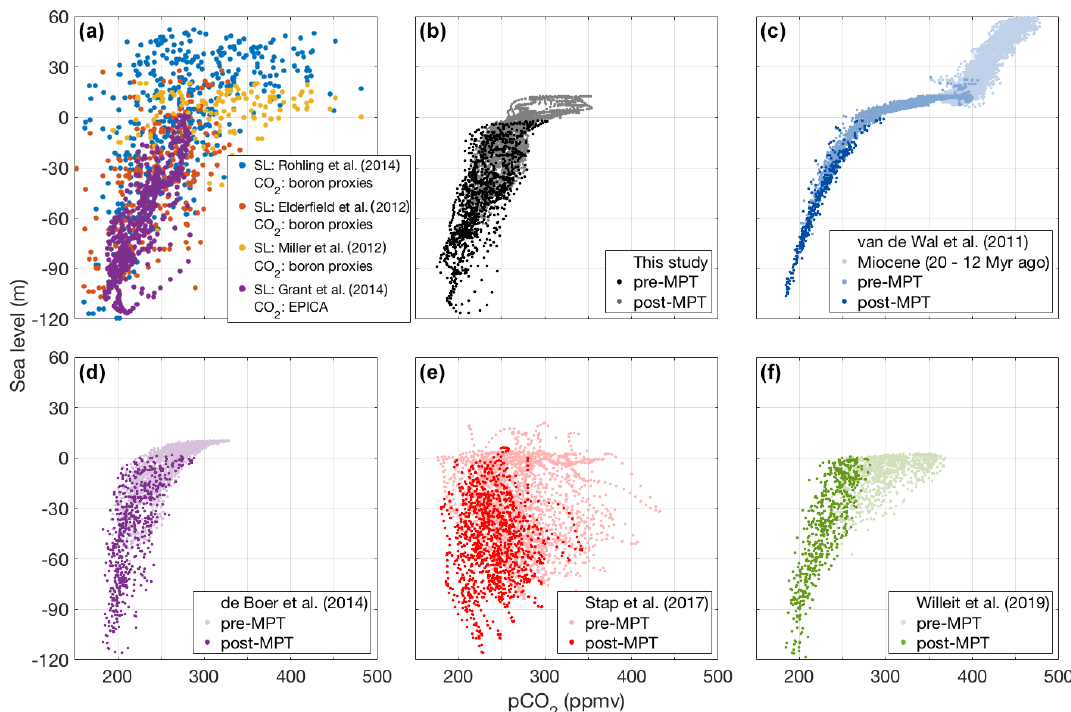
Figure 8. (a) Sea level vs. atmospheric CO 2 from proxy data. Blue: sea-level data from Rohling et al. (2014; last 5Myr) vs. boron isotope CO 2 data. Red: sea-level data from Elderfield et al. (2012; last 1.5Myr) vs. boron isotope CO 2 data. Gold: sea-level data from Miller et al. (2012) and Naish et al. (2009; 3.4–2.3Myr ago) vs. boron isotope CO 2 data. Purple: sea-level data from Grant et al. (2014; last 500kyr) vs. the EPICA Dome C ice-core record (Bereiter et al., 2015). (b–f) Reconstructed sea level and atmospheric CO 2 from different modelling studies ( b : this study; c : van de Wal et al., 2011; d : de Boer et al., 2014; e : Stap et al., 2017; f : Willeit et al., 2019), separated into pre- and post-MPT values. De Boer et al. (2014; d ) did not explicitly model CO 2 , calculating only a global mean temperature change. We